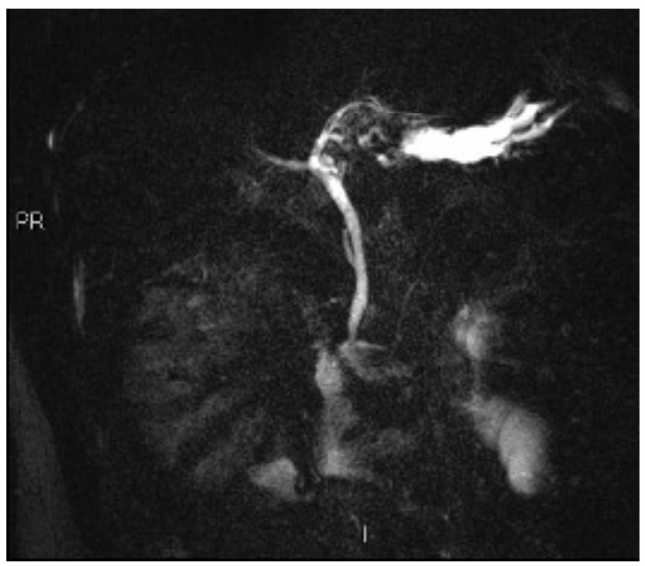
Figure 7. Cholangio-MRI.jpg. Consequently, in order to obtain a histological diagnosis, a percutaneous ultrasound- guided needle biopsy was